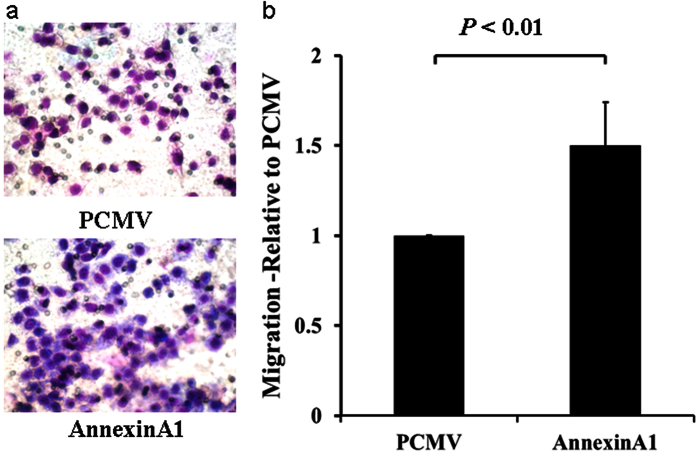
Overexpression of Annexin A1 in AGS cell promotes migration.Migration assay was conducted in AGS cells transfected with an expression plasmid carrying Annexin A1 cDNA or the empty vector PCMV using 24-well Transwell chambers. (a) Representative images of migrated cells in PCMV and Annexin A1 plasmid transfected cells. (b) Cell migration was assessed by counting the number of AGS cells that migrated through the transwell insert by light microscopy on 3 independent membranes, then normalized against the NC treated cells to determine the relative ratio.